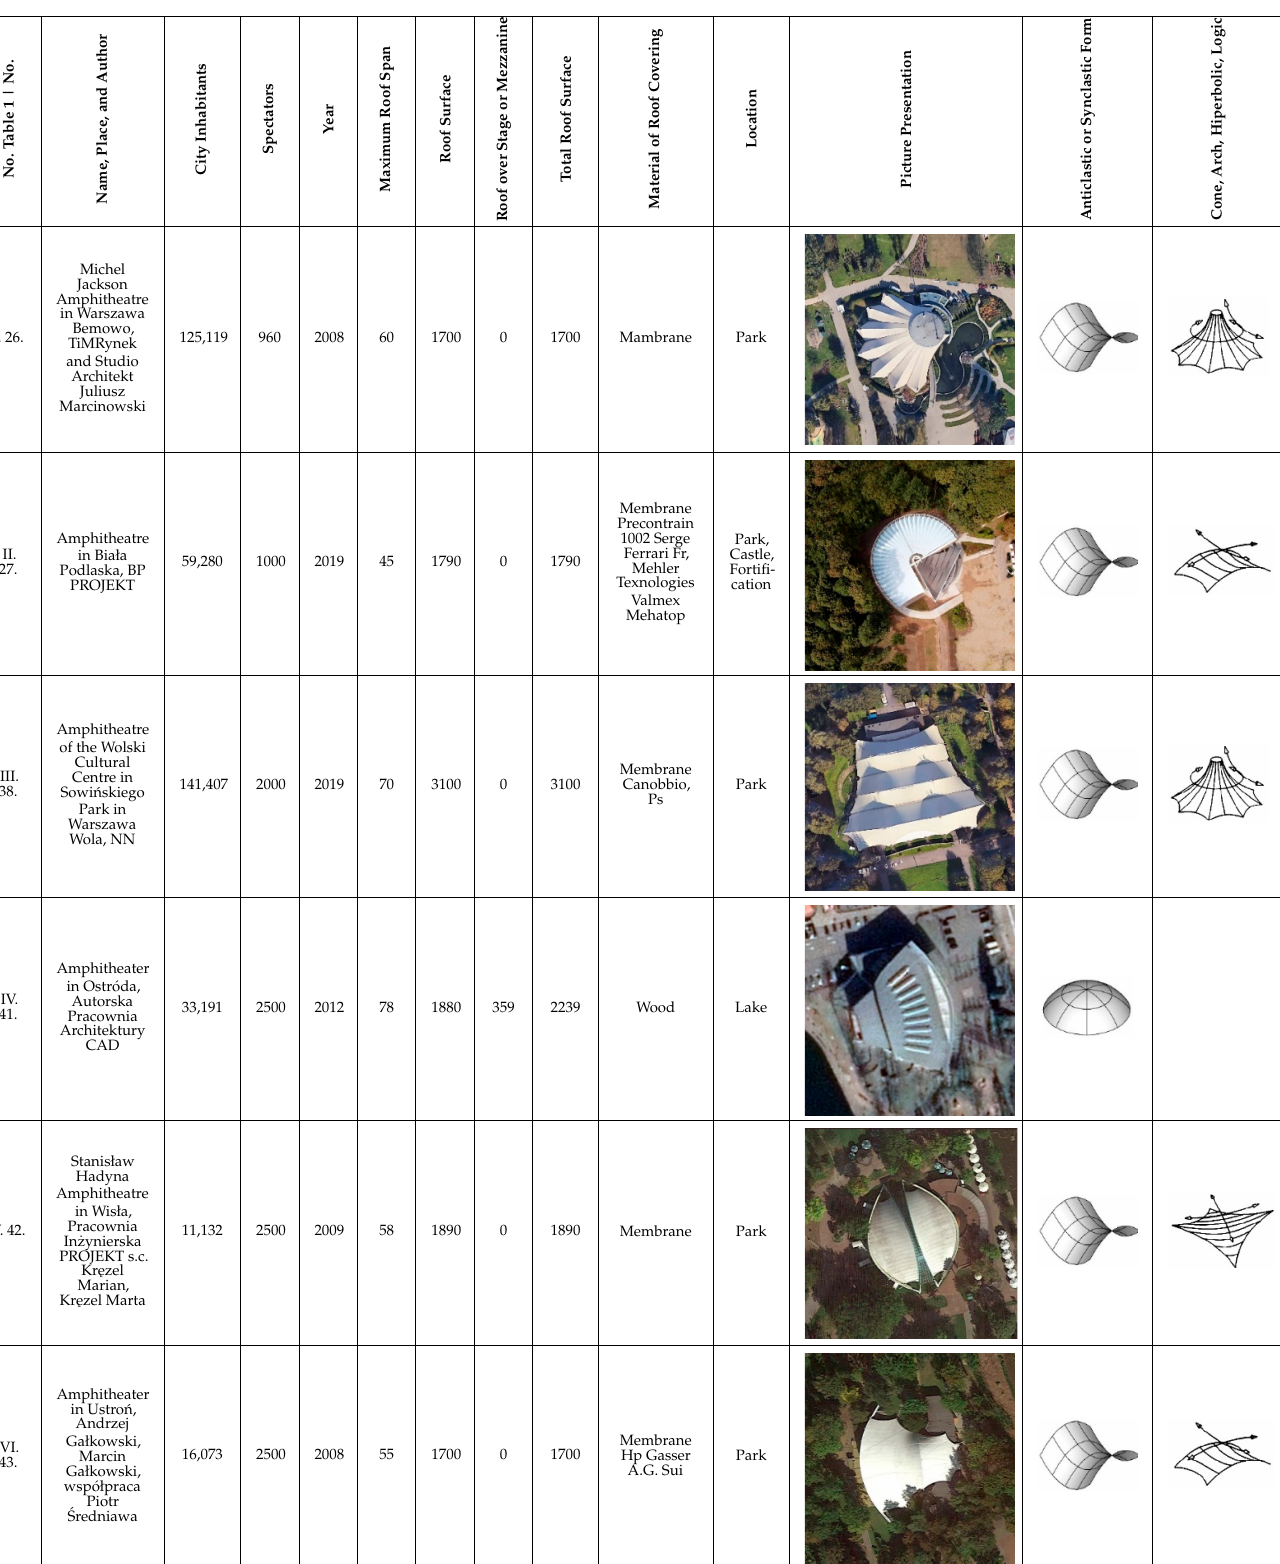
Table 2. Contemporary odeons in Poland, ordered by number of spectators. Original research. The odeons are shown on the map in Figure 5, following the Roman numbers in column